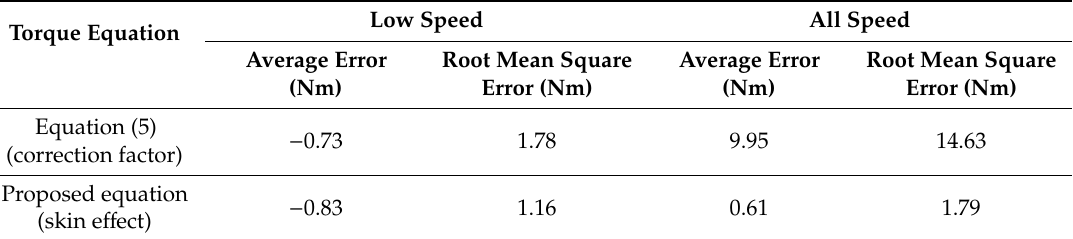
Table 2. Performance comparison. RMSE—root mean square error.